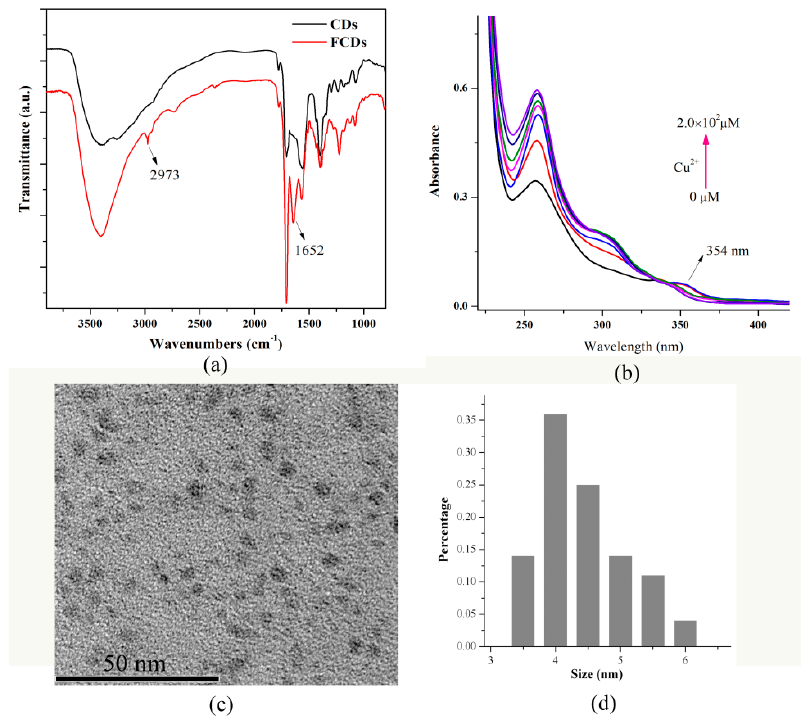
Figure 3. ( a ) IR spectra of carbon dots (CDs) and FCDs; ( b ) UV spectra of FCDs upon addition of Cu 2+ ; ( c ) TEM and ( d ) the size distribution histogram of the FCDs.